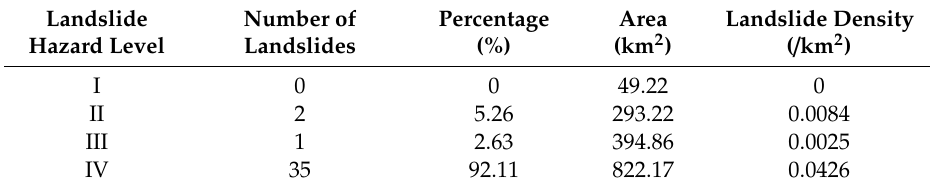
Table 9. The landslides statistical results according to landslide susceptibility